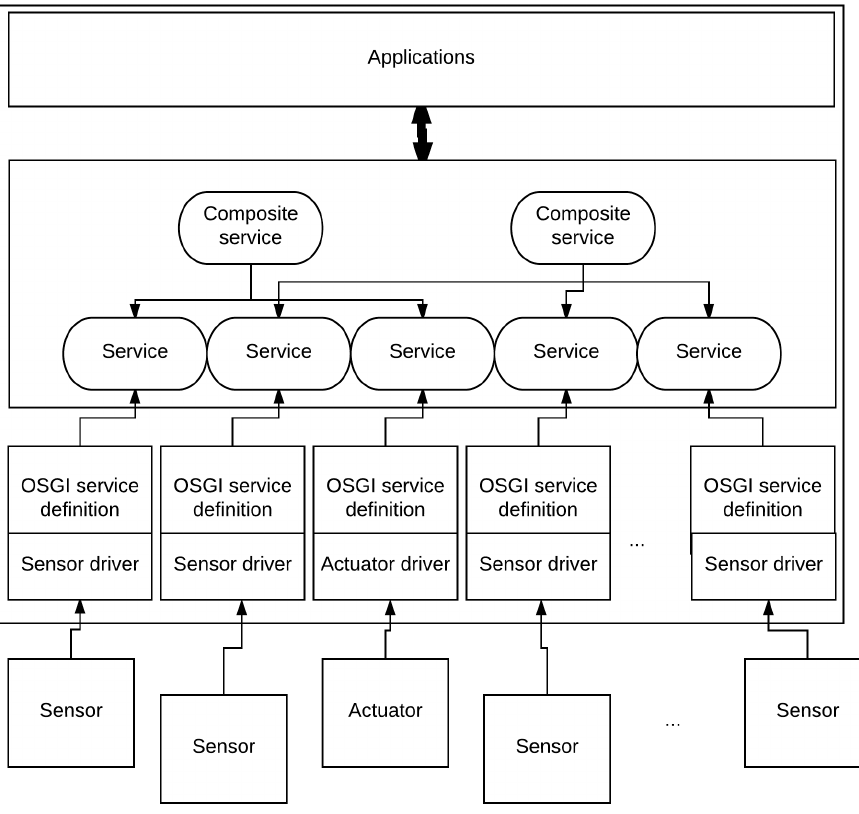
Figure 2. The Gator Tech architecture. OSGI: Open Service Gateway